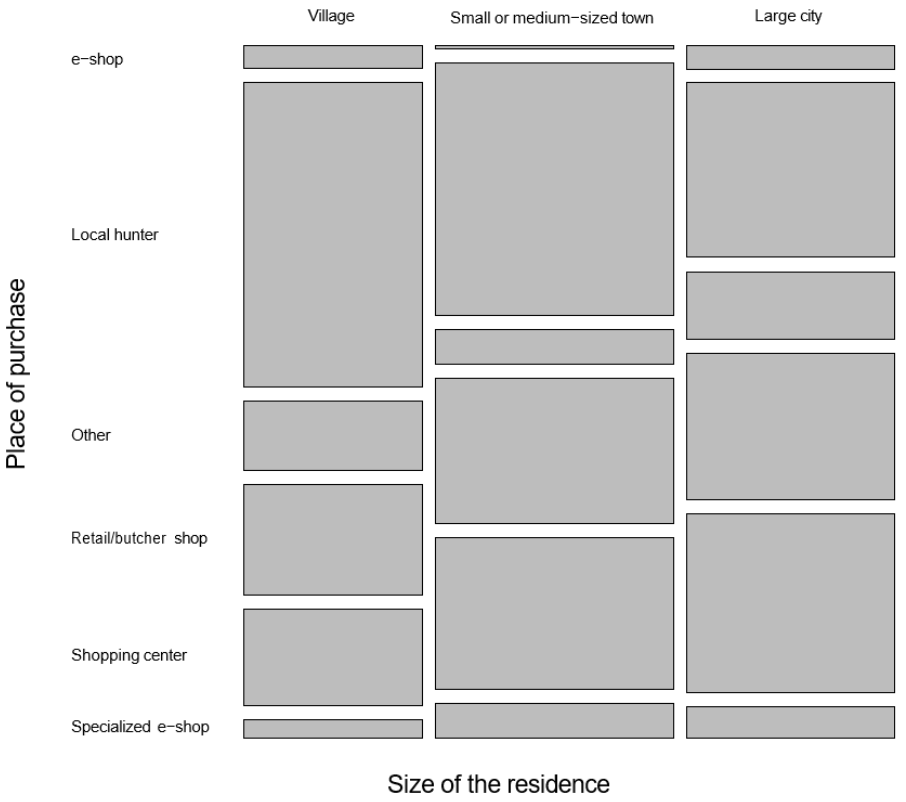
Figure 5. The mosaic display of the relationship between the size of the residence and the place the meat was purchased ( n = 472) *.* A specialised e-shop is an e-shop that specialises in the sale of game meat only, whereas an e-shop is meant as a general grocery shop in our research.